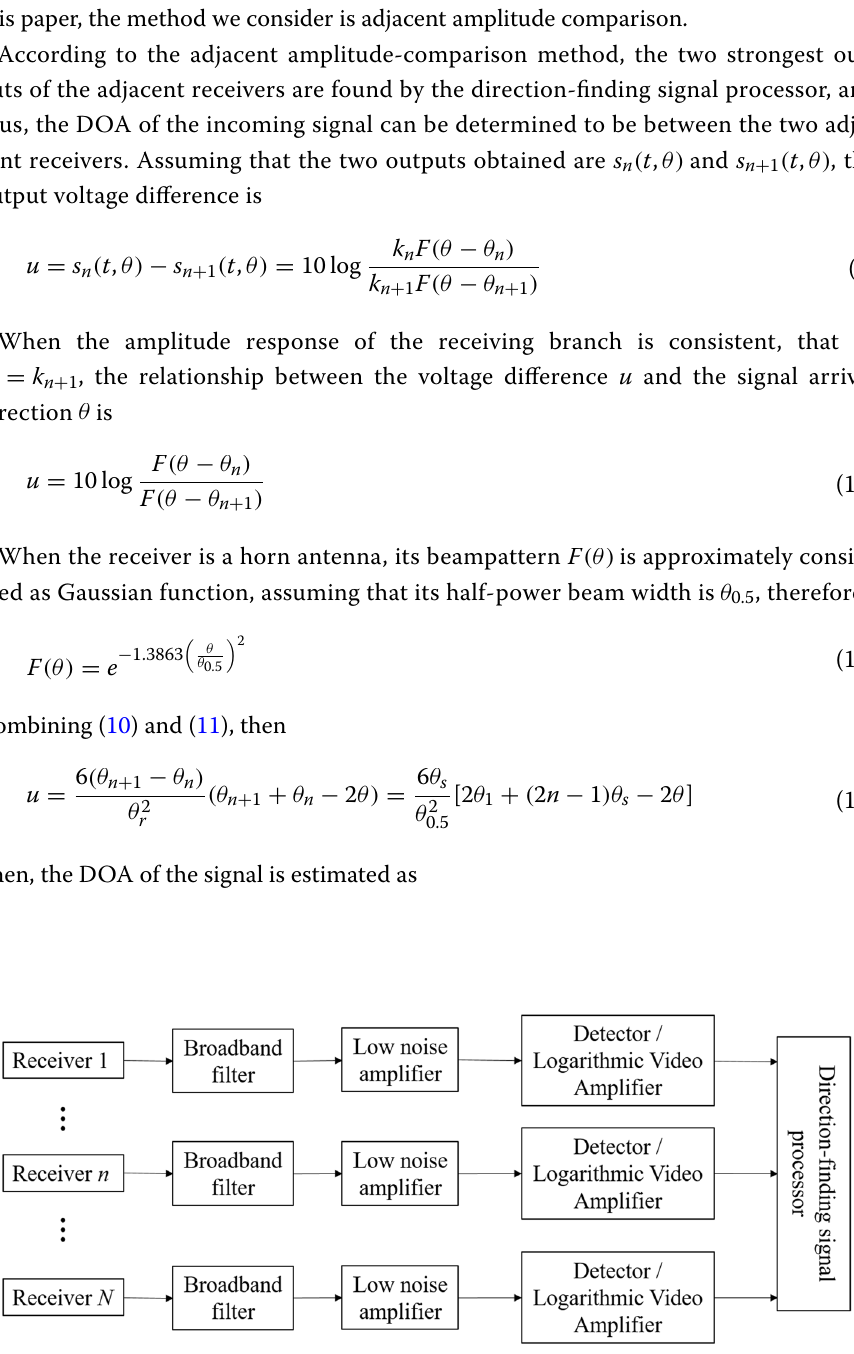
Fig. 3 Direction-finding principle of the amplitude-comparison